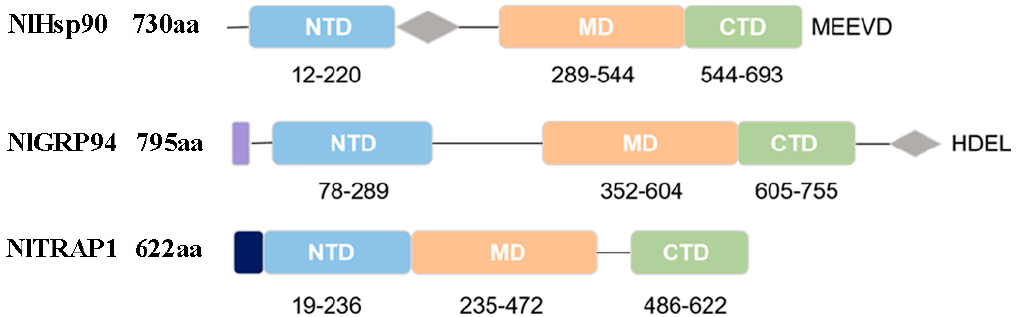
Figure 1. Schematic diagram of the domains of the three brown planthopper (BPH) Hsp90 homologs. Purple , endoplasmic reticulum (ER) retention sequence; black , mitochondria targeting sequence; blue , N-terminal domain (NTD); gray , charged linker region; orange , middle domain (MD); green , C-terminal domain (CTD).